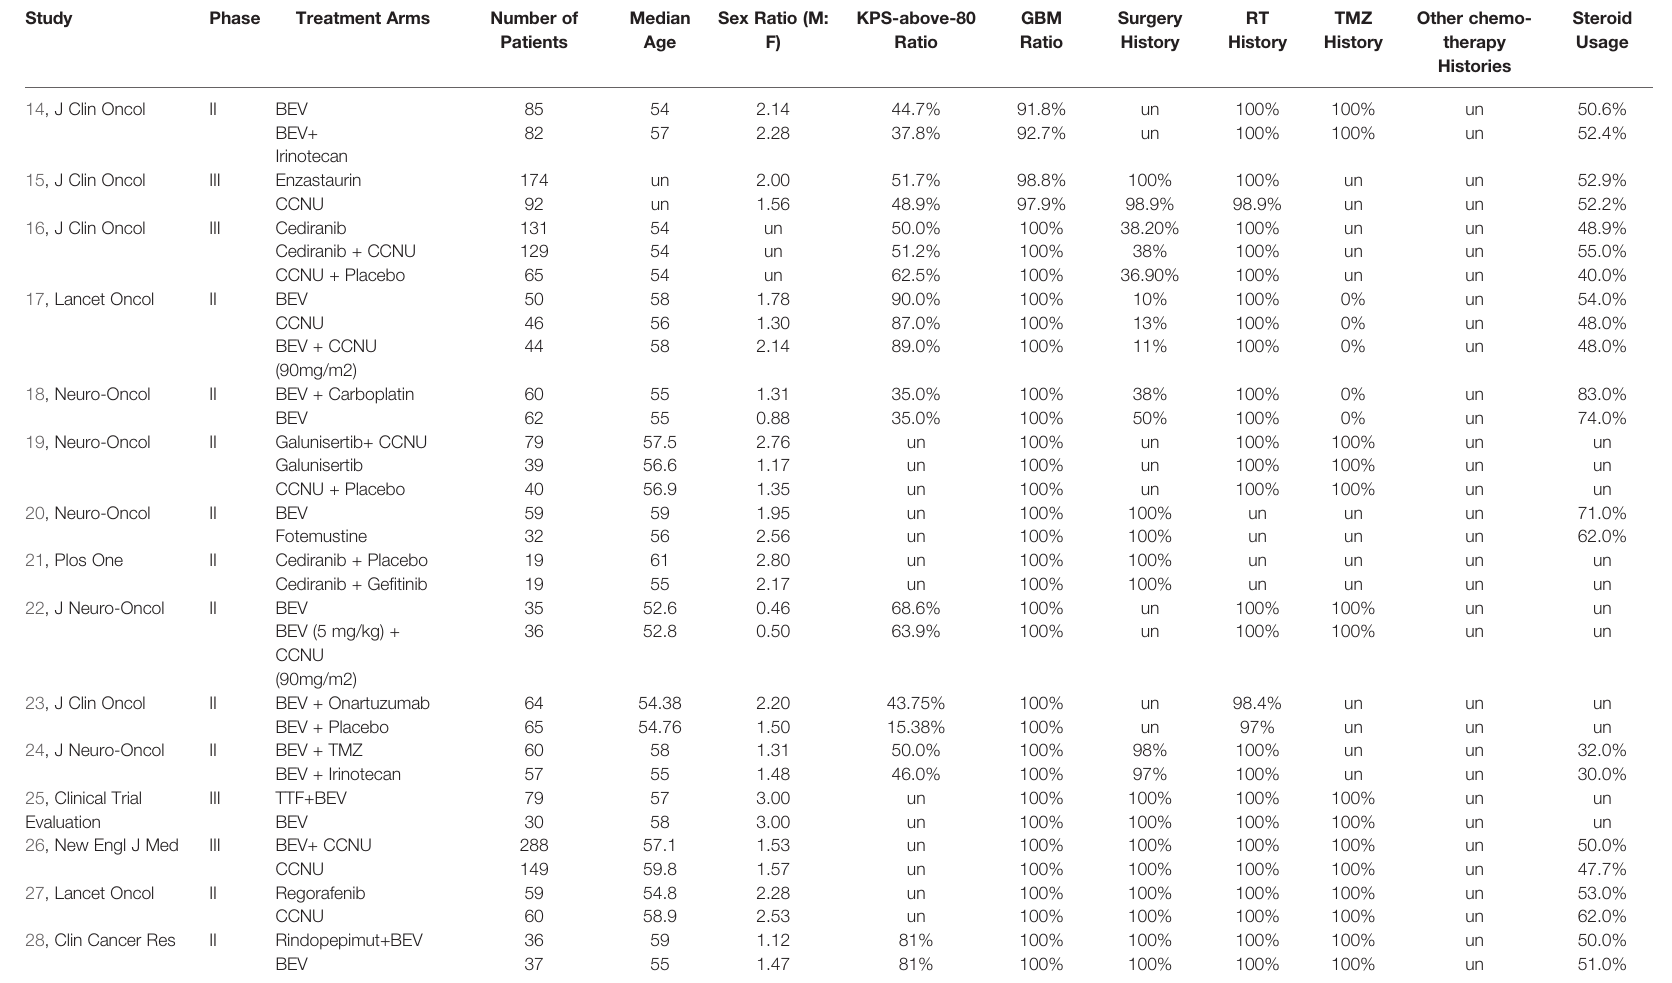
TABLE 1 | Baseline characteristics of included